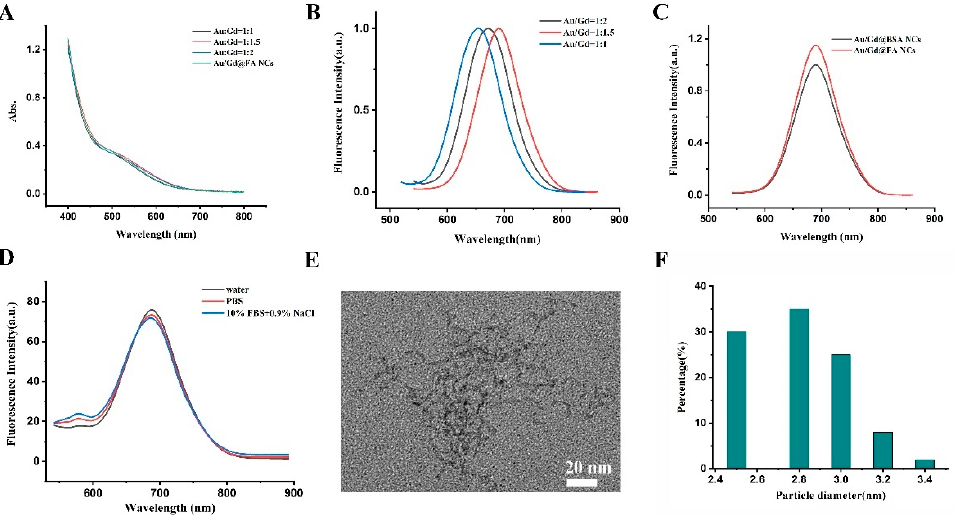
Figure 1. ( A ) UV spectrum of Au/Gd@BSA NCs prepared by different mole ratios and